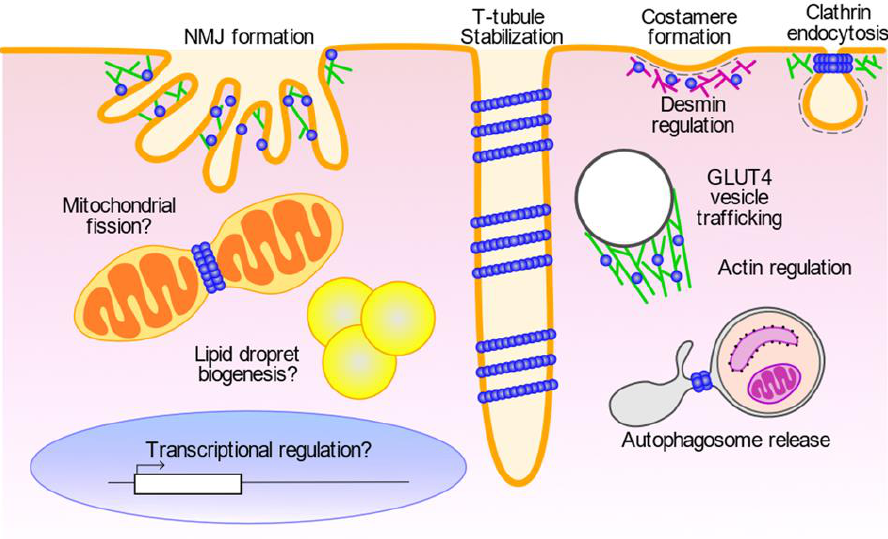
Figure 5. Multiple functions of dynamin 2 in skeletal muscle cells. Dynamin 2 (blue) is involved in multiple processes in muscle cells such as T-tubule biogenesis, NMJ formation, costamere formation, endocytosis and vesicle trafficking, autophagy and lipid homeostasis. Dynamin 2 regulates clathrin-dependent and -independent endocytosis of glucose